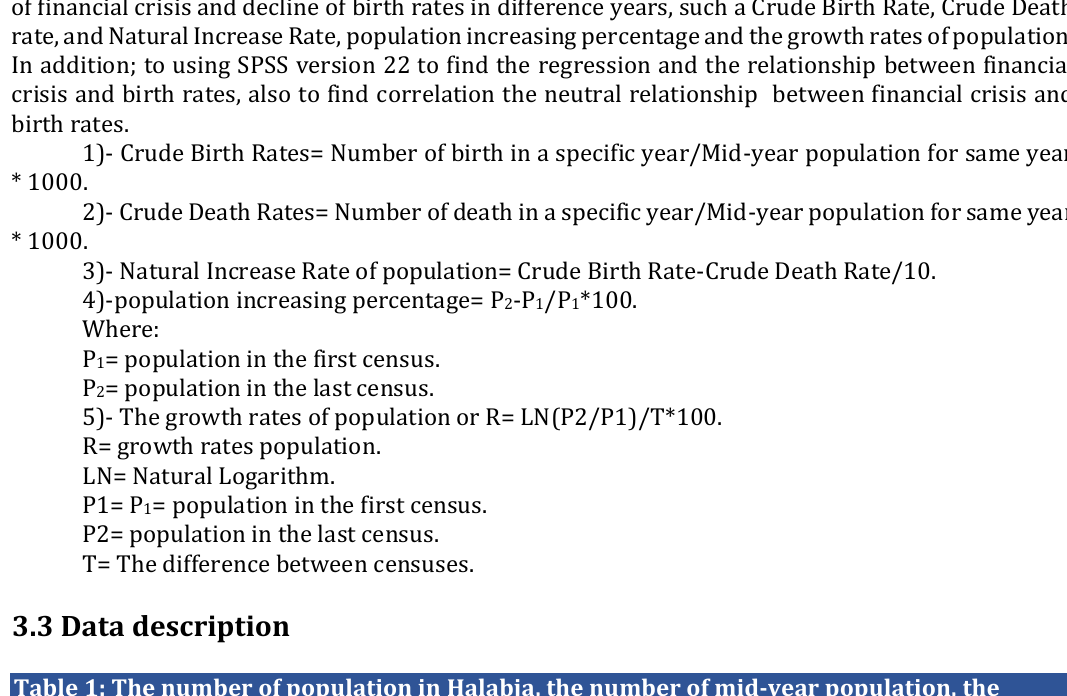
Table 1: The number of population in Halabja, the number of mid-year population, the number of birth and death